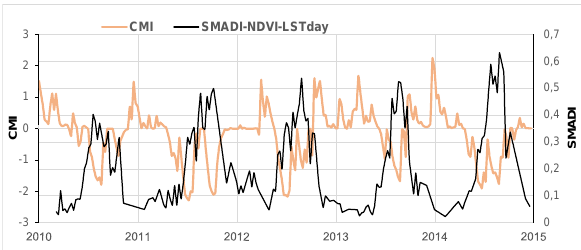
Figure 7. Time evolution of SMADI (NDVI and LST day version) and CMI at